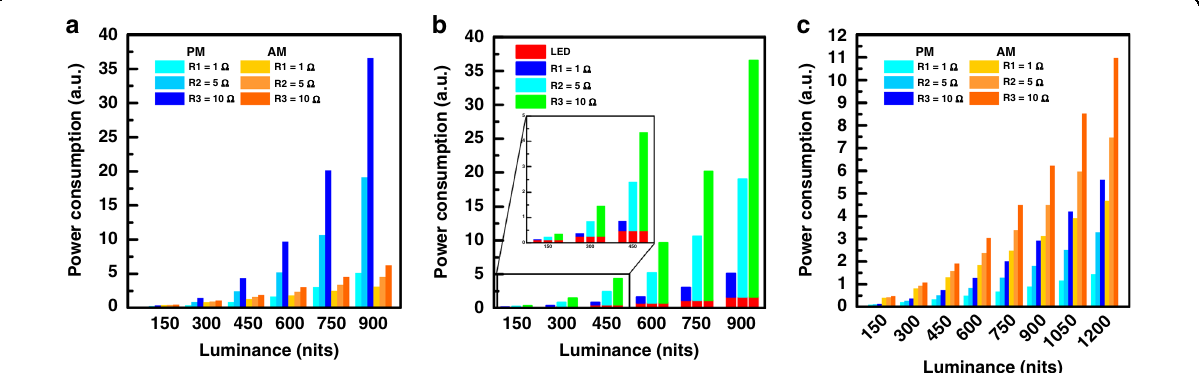
Fig. 4 Power consumption comparison. a Power consumption of AM and PM driving methods with three different parasitic resistances on power line; b Power consumption caused by mini-LED and parasitic resistor on power line for PM driving method; c Power consumption of AM and PM driving with multiple scanning scheme for three different parasitic resistances on power